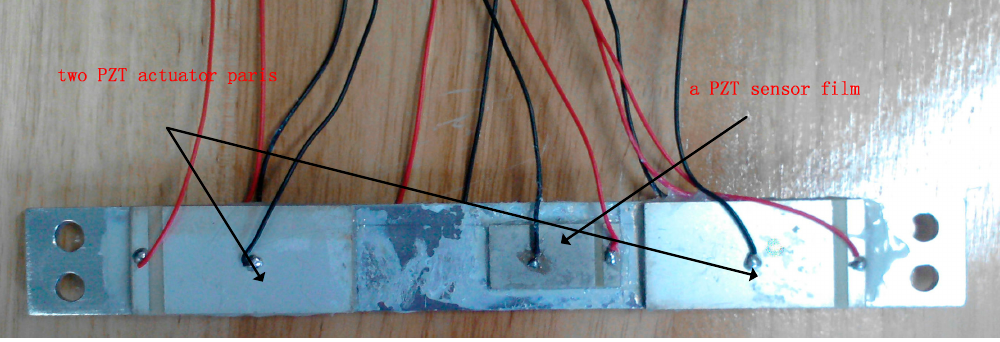
Figure 15. Smart beam. Figure 15. Smart